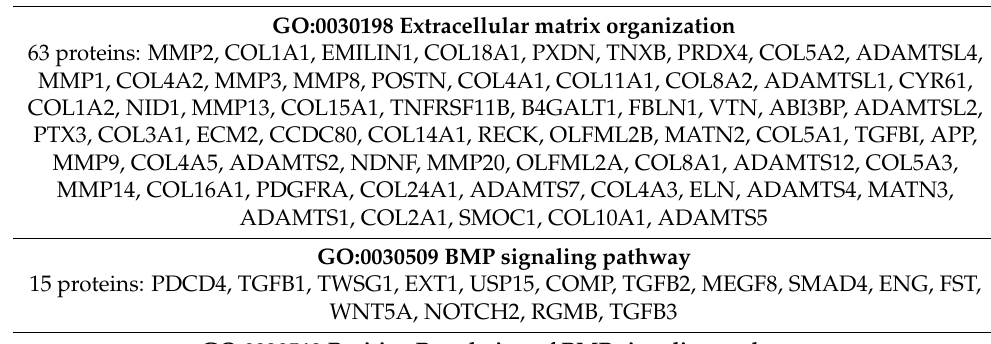
Table 1. Summary of proteins in lyophilized pooled CM representing selected biological processes related to bone